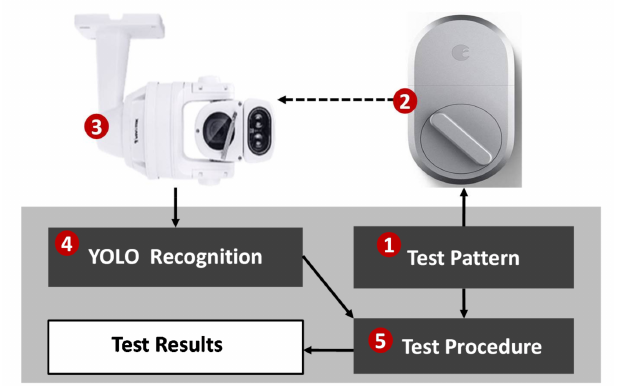
Figure 21. Visual test example: door lock.